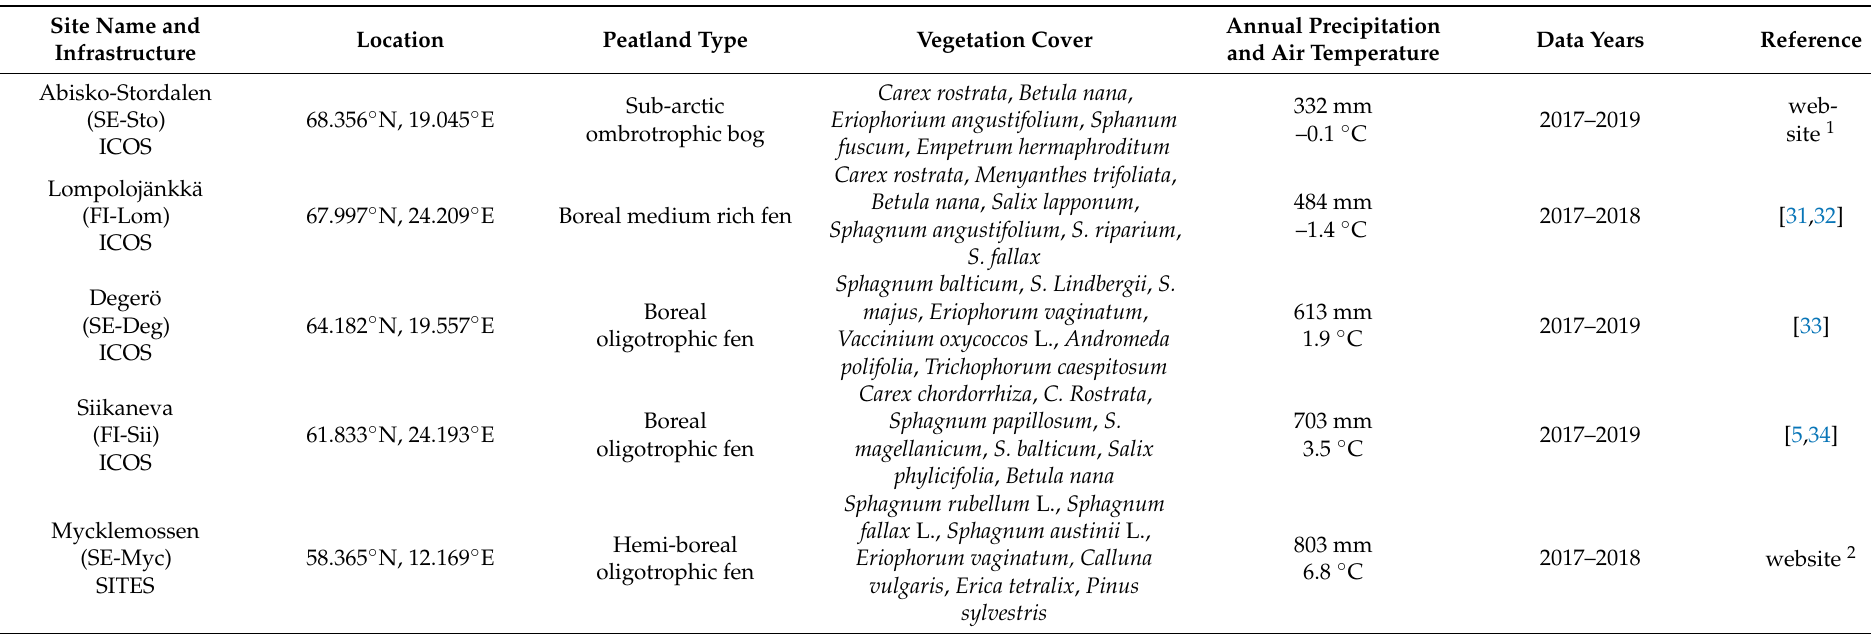
Table 1. The study sites, their characteristics, and references for additional site descriptions. Temperature and annual precipitation values are 1981–2010